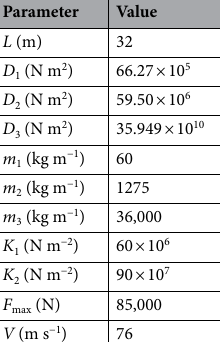
Table 1. Geometric and material parameters of railway track system (Yulin et al. 33 and Jiang et al. 34 ).